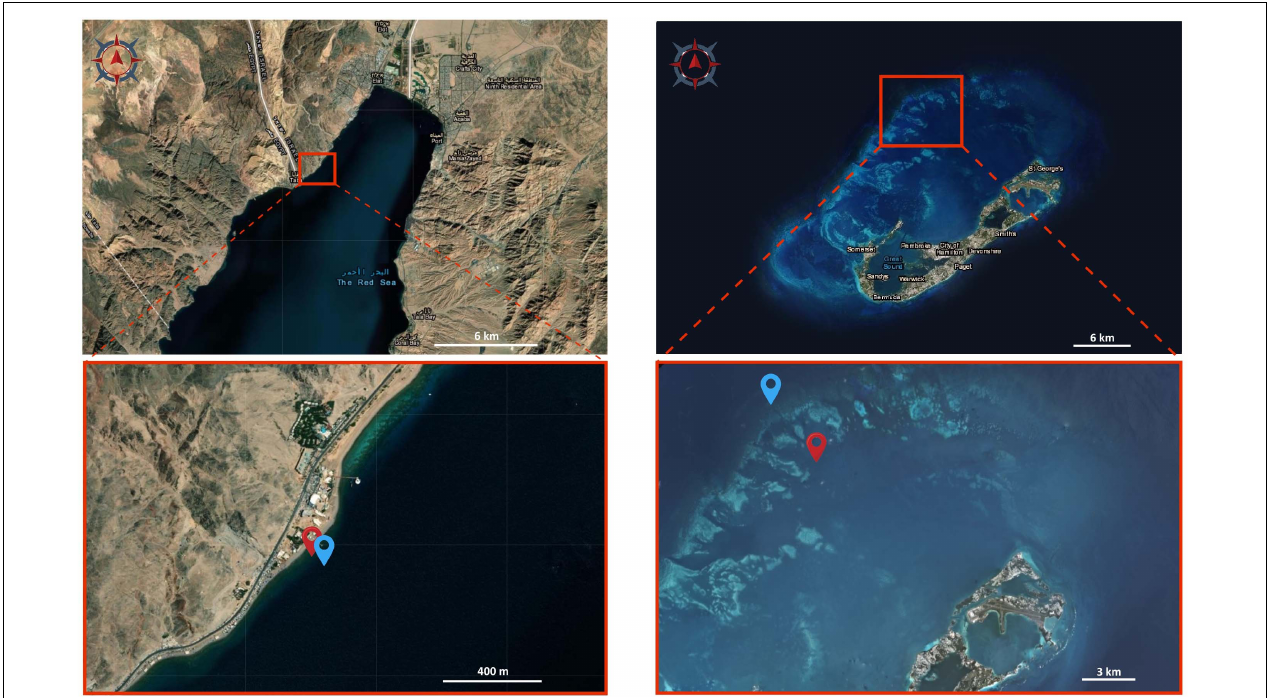
FIGURE 4 | Satellite images of the study sites. Images of Eilat (left) and Bermuda (right) showing the sampling locations. Red locators in the bottom images indicate the shallow reefs, blue locators indicate the mesophotic reefs. Image source: Earthexplorer.usgs.gov.